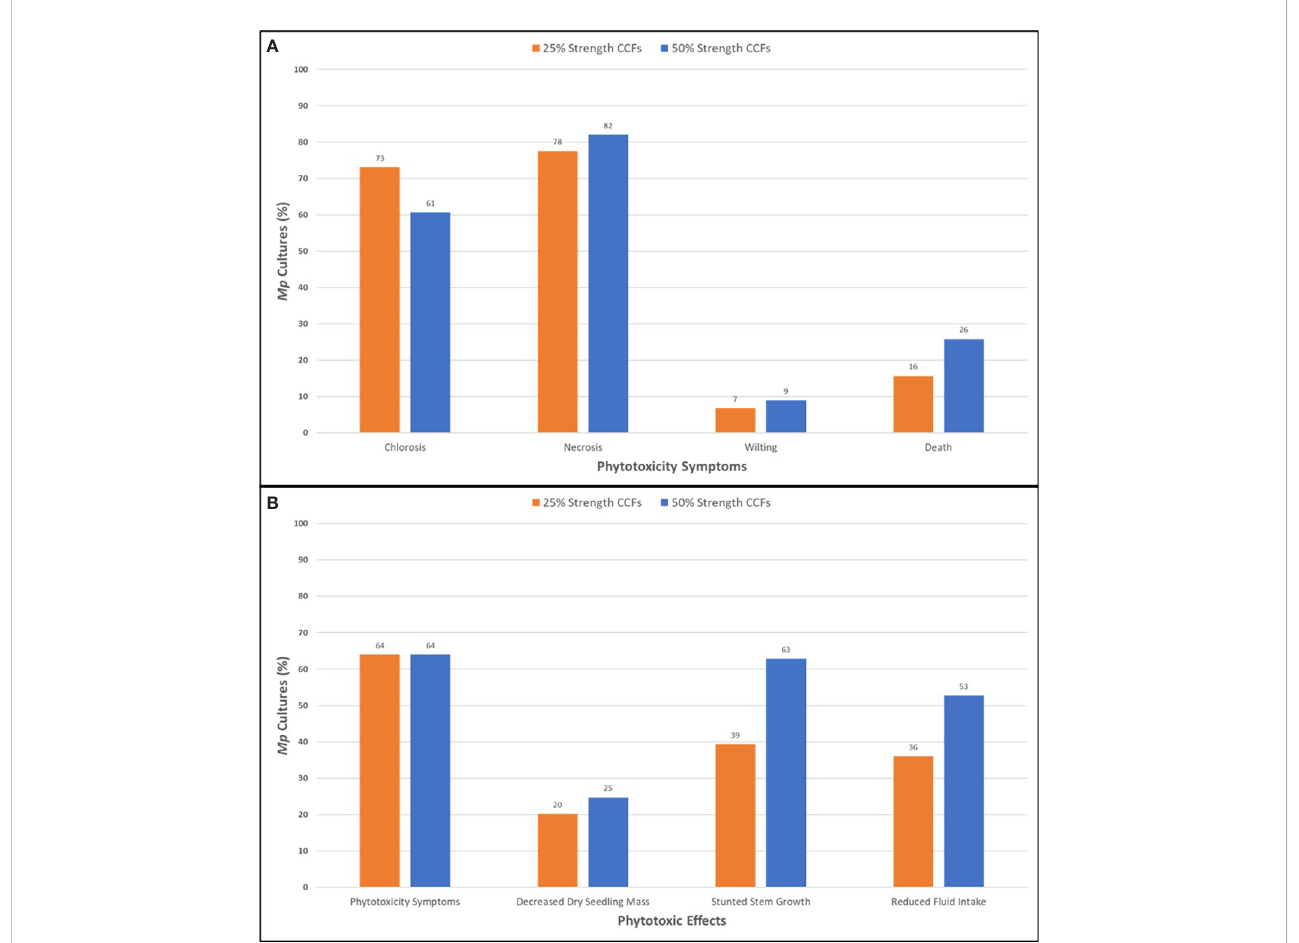
FIGURE 2 Phytotoxic symptoms (A) and effects (B) of adding M. phaseolina cell-free culture fi ltrates to the hydroponic culture medium of soybean seedlings of the germplasm line DT97-4290 after 96 hours incubation. Mp , M. phaseolina ; CCF, cell-free culture fi